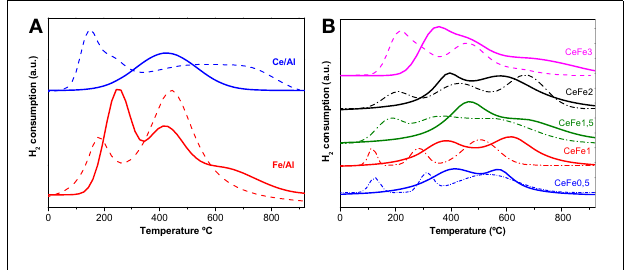
FIGURE 5 | TPR-H 2 profiles of the supports (full lines) and their corresponding gold catalysts (dashed lines). (A) Binary systems. (B) Ce-Fe ternary systems.